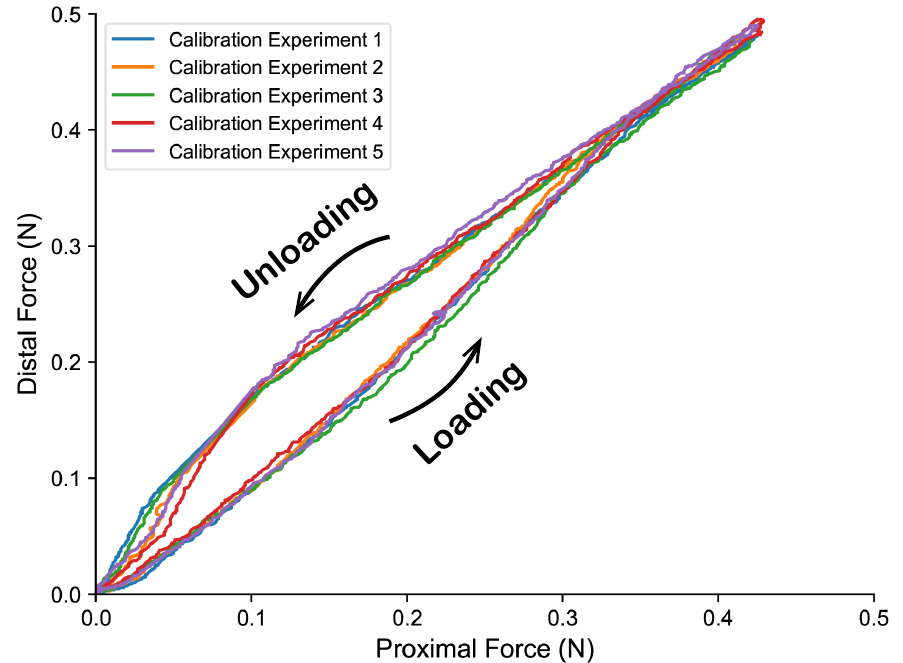
Figure 13. Hysteresis curve of the force applied to guidewire. The proximal force is measured by proximal force sensor inside VISR, and the distal force is captured by distal force sensor behind the